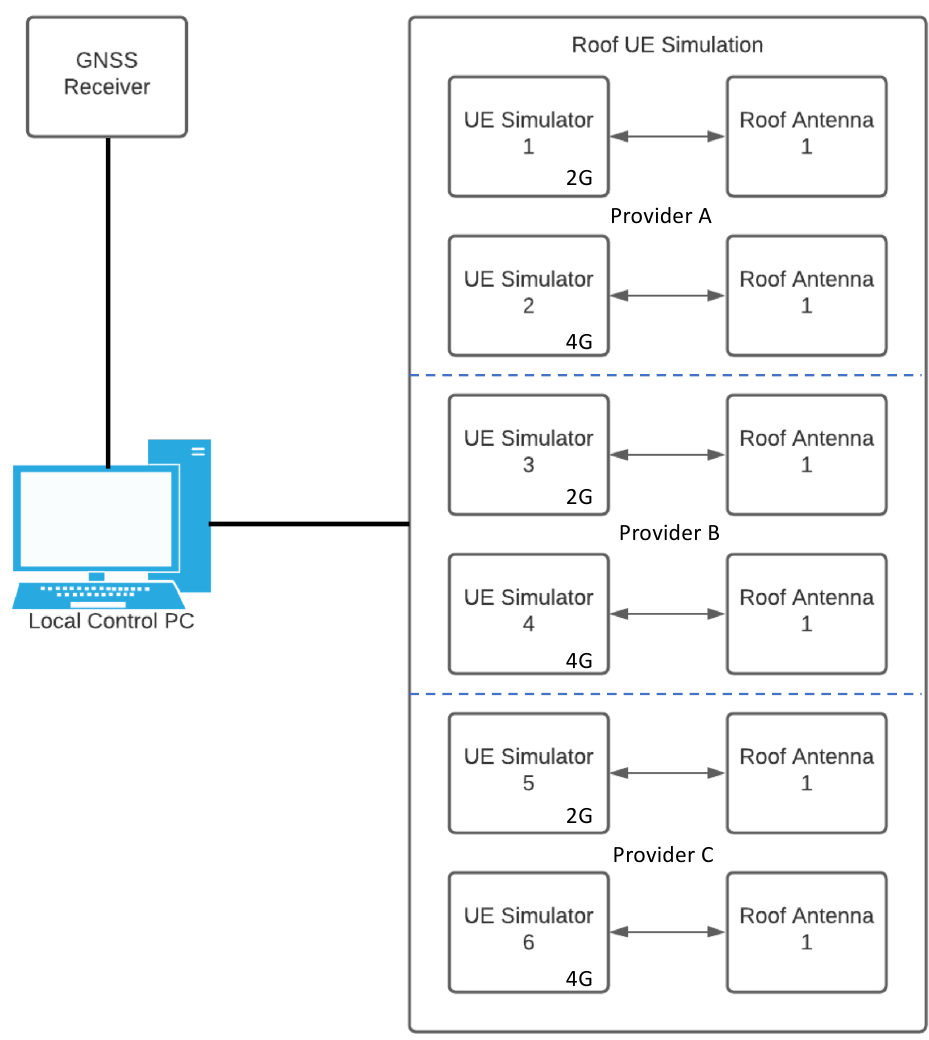
Figure 1. The setup of the measurement